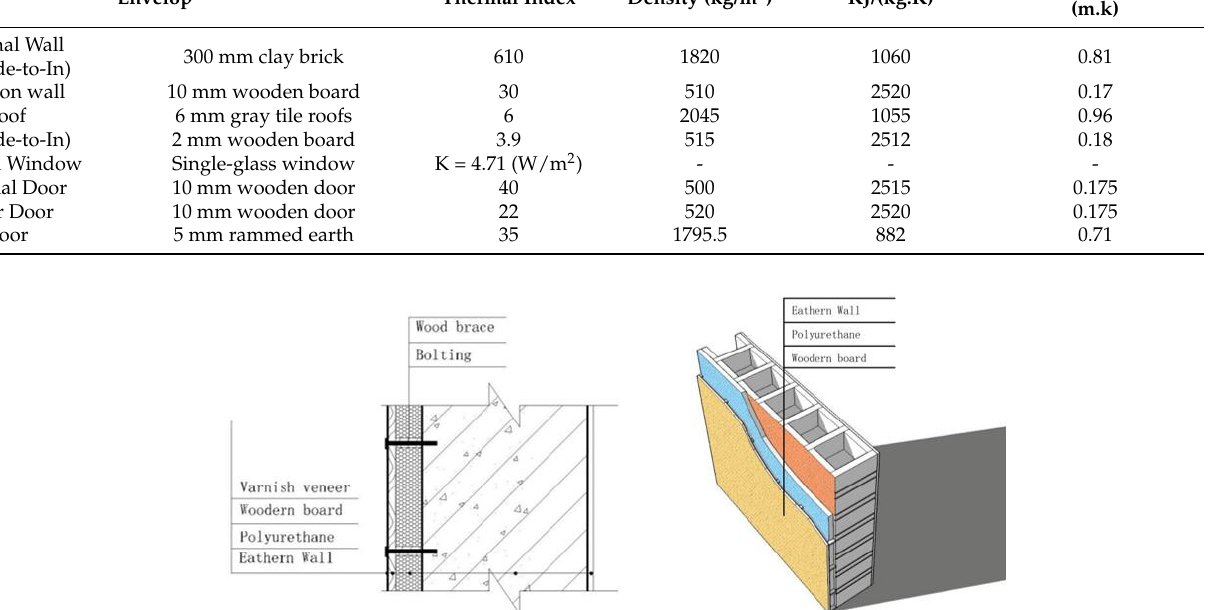
Table 6. Energy consumption.